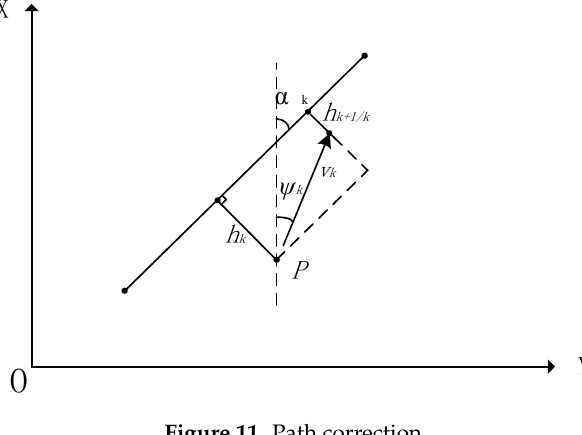
Figure 11. Path Figure 11. Path correction.